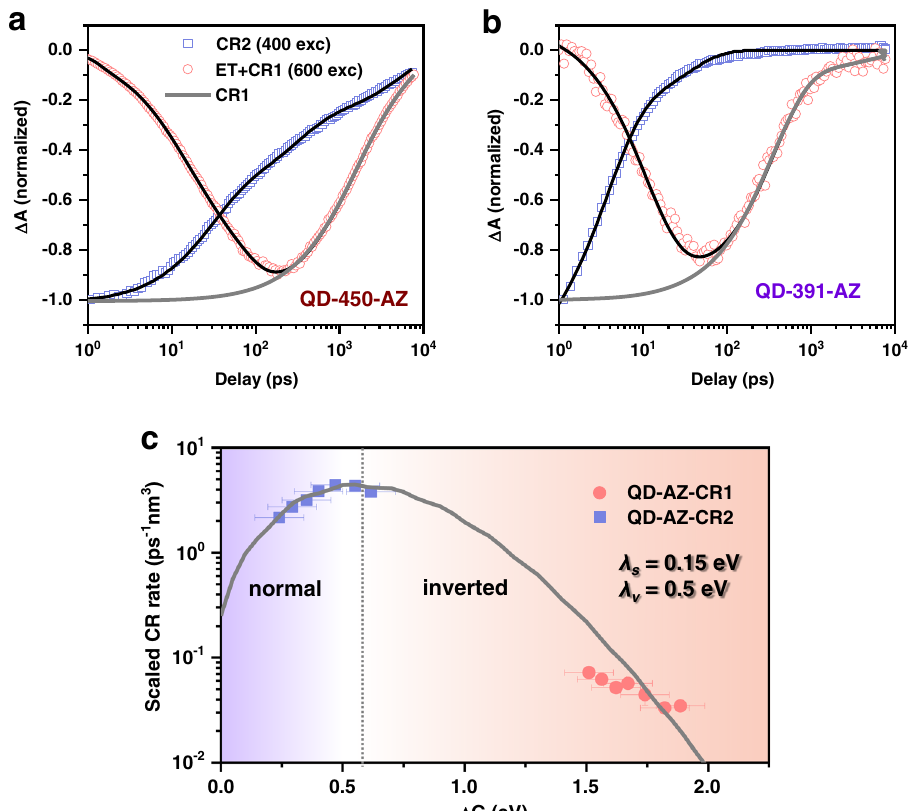
Fig. 4 Observation of a Marcus-inverted region for CR rates in QD – AZ complexes. a, b TA kinetics of the CdS QD exciton bleach feature for a QD-450- AZ and b QD-391-AZ complexes under 400 nm (blue squares) and 600nm excitation (red circles). The black solid lines are multi-exponential fi ts to XB kinetics. The kinetics of CR1 pumped at 600 nm (gray solid lines) is obtained by deconvoluting the ET kinetics from XB kinetics. c Surface-electron-density scaled CR-1 (red circles) and CR-2 rates (blue squares) as a function of size-dependent driving forces ( − Δ G ) in QD – AZ complexes. The gray solid line is a fi t to Marcus theory (Eq. 2). Horizontal error bars stand for the accuracy of the electrochemical experiments for energy levels (±0.1 eV), whereas vertical errors are the fi tting errors of the CR